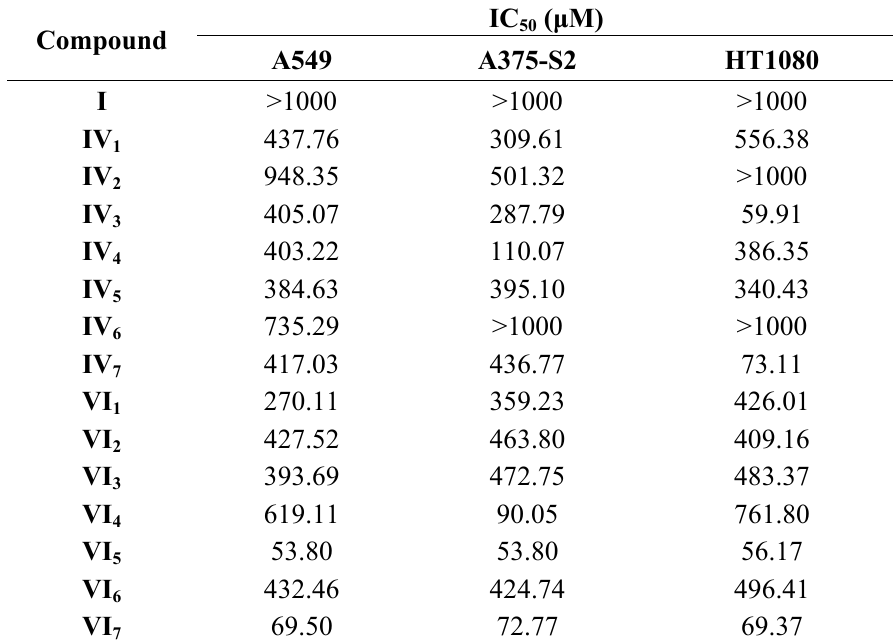
Table 1. The antiproliferative effects of target compounds in A549, A375-S2 and HT1080